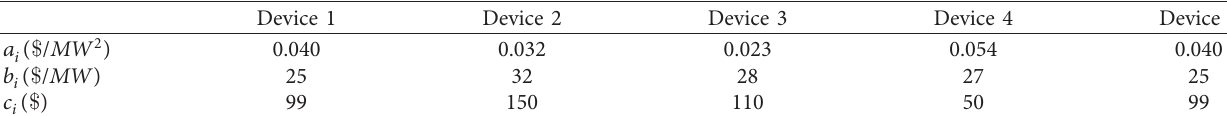
Table 1: The parameters of port power